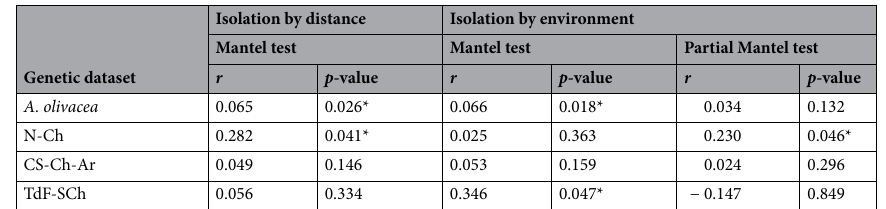
Table 1. Results of Mantel tests and partial Mantel tests performed to evaluate models of isolation by distance (IBD) and isolation by environment (IBE) in Abrothrix olivacea and their mitochondrial phylogroups (N-Ch, CS-Ch-Ar, TdF-SCh; see text). For each model evaluation values of Mantel statistic based on Pearson’s product- moment correlation index ( r ) and its significance ( p -value) are presented. Significant values ( p -value ≤ 0.05) are indicated with an